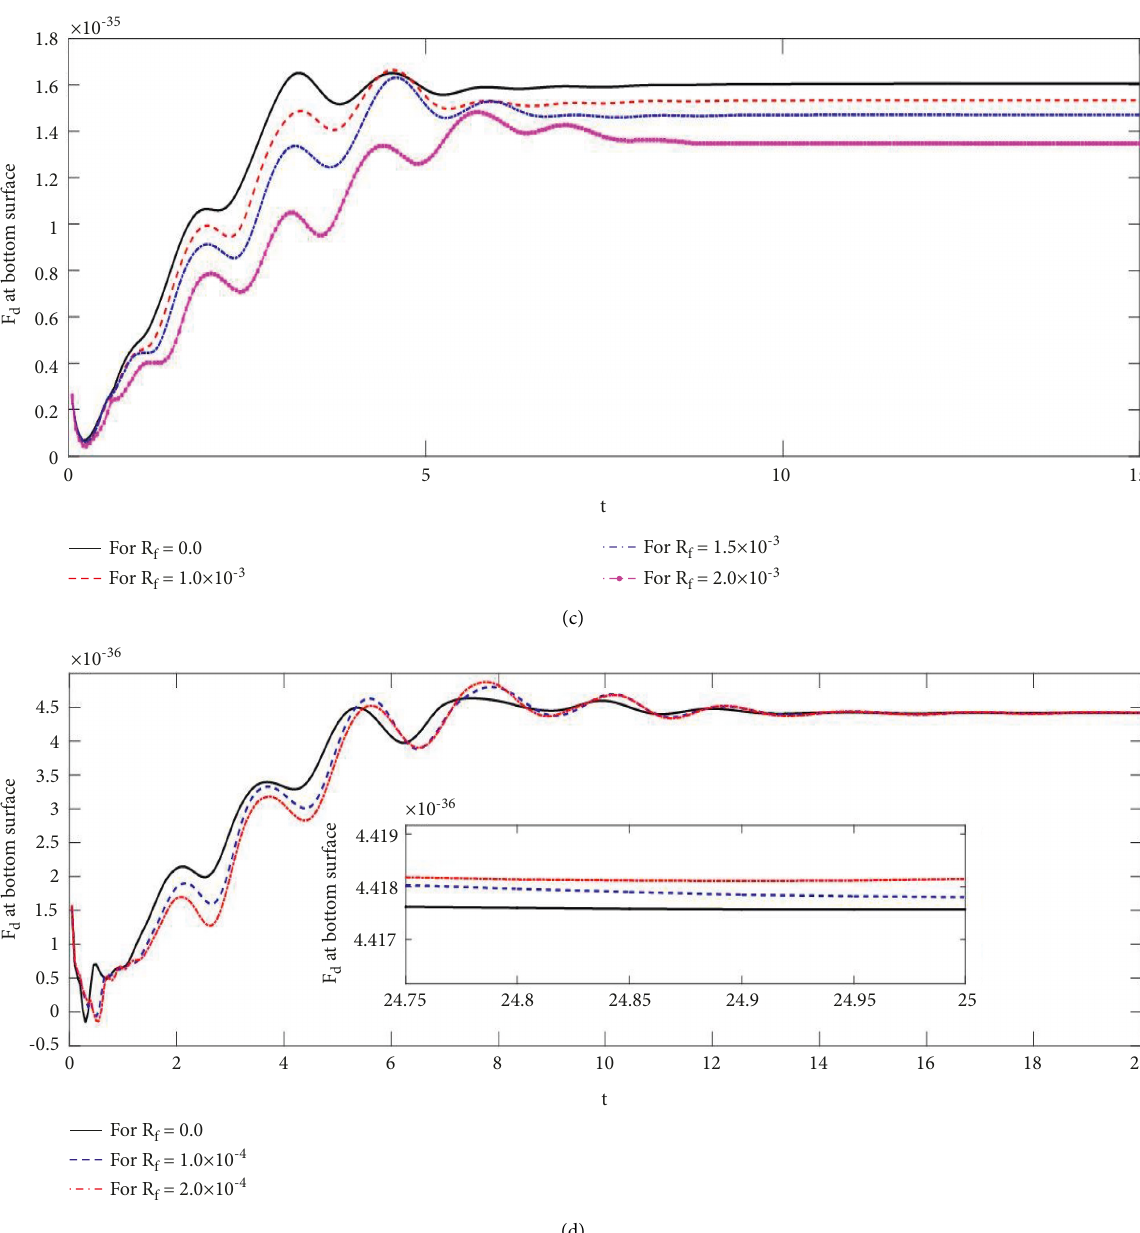
� 500, (b) for Re � 1000, (c) for Re � 2000, and f . (a) For Re